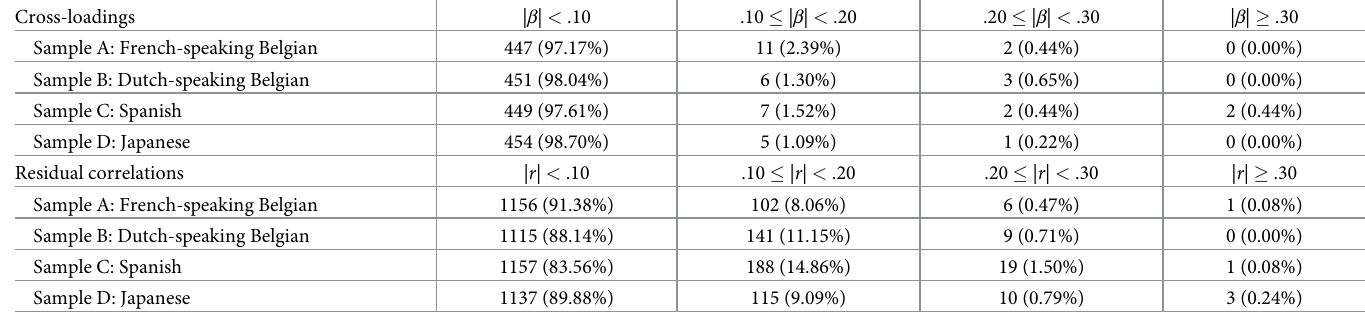
Table 5. Frequency distribution of the strength of cross-loadings and residual correlations in the model with cross-loadings (prior variances = 0.1) and residual cor- relations ( d = 200). Cross-loadings | β | < .10 .10 � | β | < .20 .20 � | β | < .30 | β | �